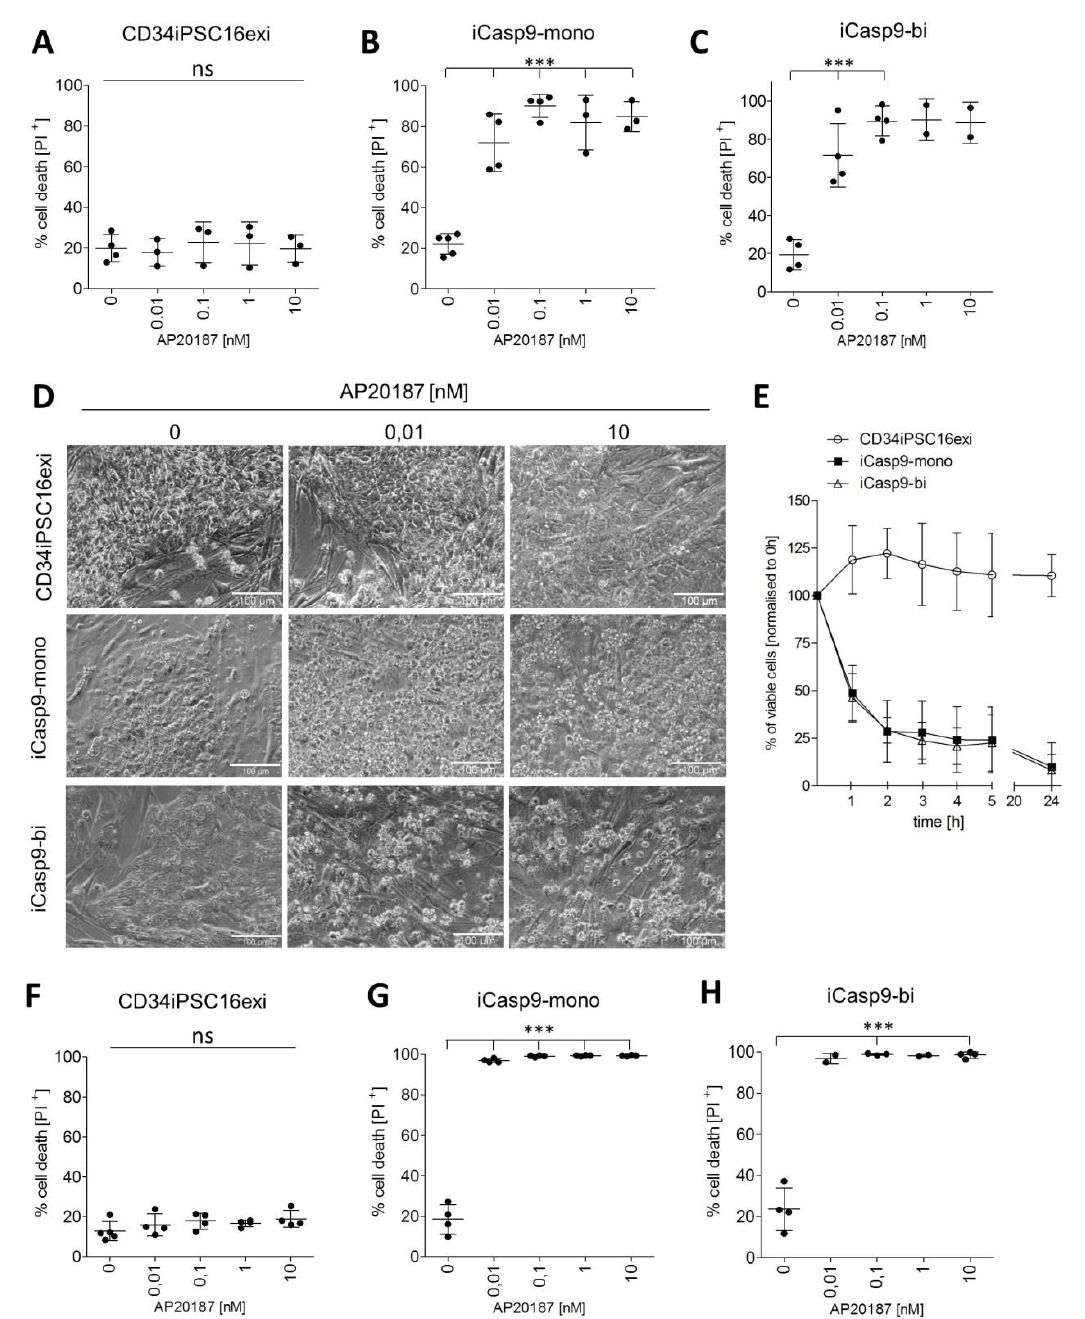
Figure 2. Induction of the iCasp9-mediated apoptosis in iPSCs. Percentage of dead cells according to propidium iodide (PI) staining after administration of 0.01 to 10 nM of the AP20187 dimerizer in CD34iPSC16exi iPSCs ( A ), iCasp9-mono iPSCs ( B ), and iCasp9-bi iPSCs ( C ) cultured on MEF feeders. (mean ± SD, ***P < 0.0001, ns—not significant) ( D ) Phase-contrast images of CD34iPSC16exi as